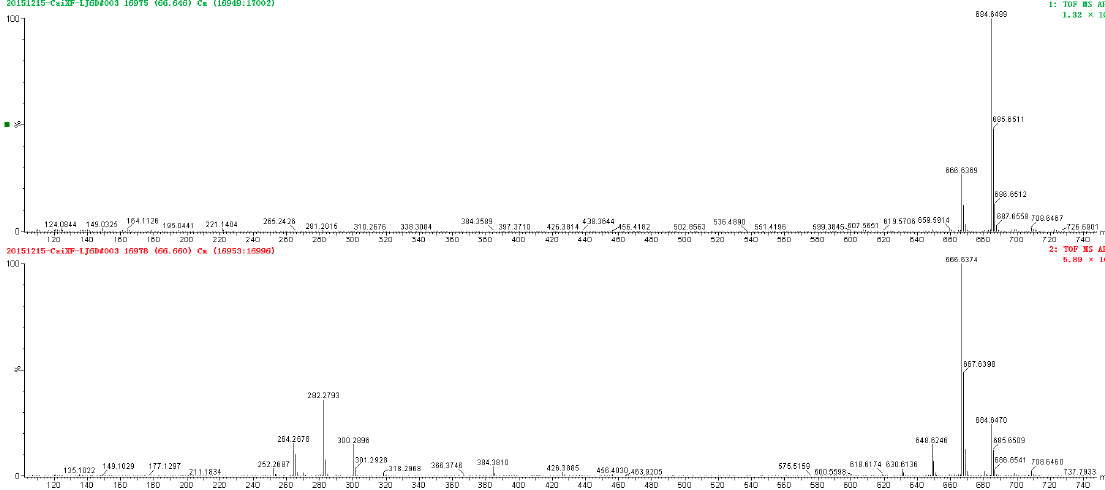
Figure 4. MS and MS/MS spectrum of Cer species compound 29 . Table 2. Summary of precursor/product ion m / z values for ceramides molecular species- α -OH. Peak NO. in Figure 4